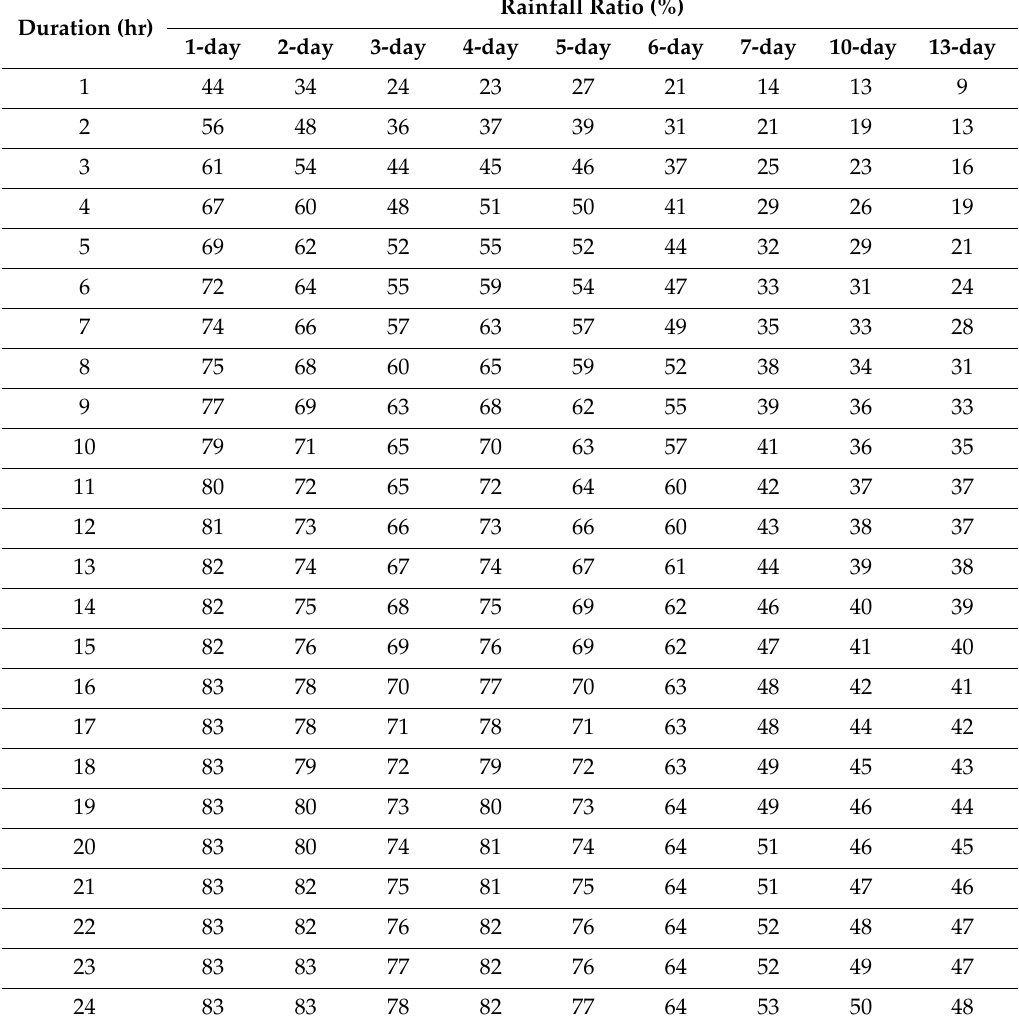
Table 7. Ratio of rainfall to total rainfall by duration according to the length of disaster occurrence